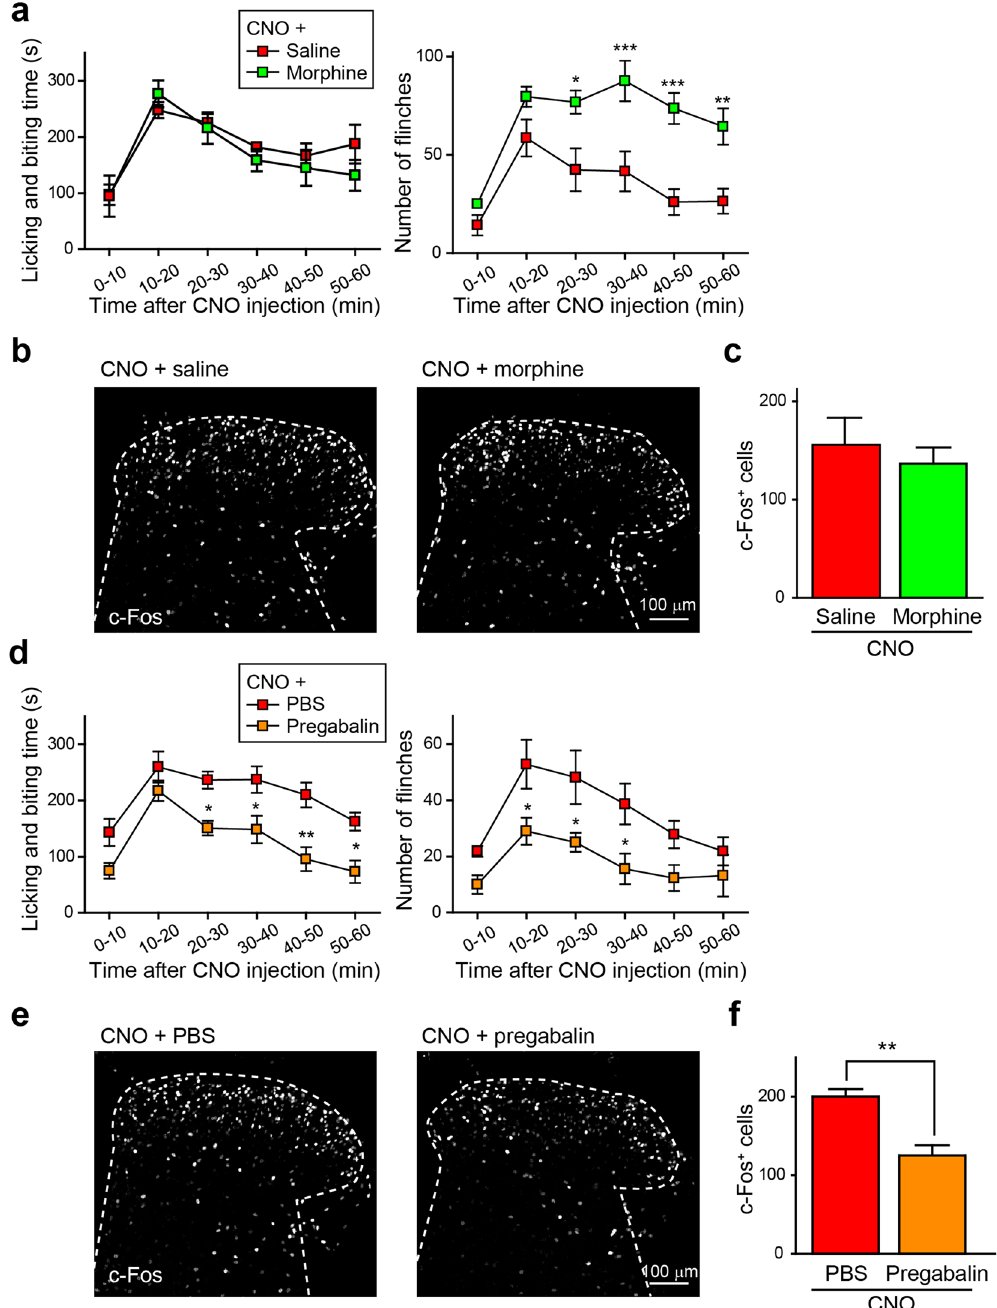
Figure 4. Effect of morphine and pregabalin on CNO-induced spontaneous nocifensive behaviours. ( a,b ) Effects of morphine (3 mg kg − 1 , s.c.) on CNO-induced nocifensive behaviours (left, licking and biting; right, flinching) (( a) n = 5; * P < 0.05, ** P < 0.01, *** P < 0.001 vs. CNO + saline) and on c-Fos + cells in the SDH. c-Fos immunoreactivity in the SDH ( b ) and quantification (( c) n = 5). ( d–f ) Effects of intrathecal administration of pregabalin (10 μ g/5 μ L) on CNO-induced nocifensive behaviours (left, licking and biting; right, flinching) ( (d) n = 6–7; * P < 0.05, ** P < 0.01 vs. CNO + PBS) and on c-Fos + cells in the SDH. c-Fos immunoreactivity in the SDH ( e ) and quantification (( f) n = 7; ** P < 0.01). Data are means ±